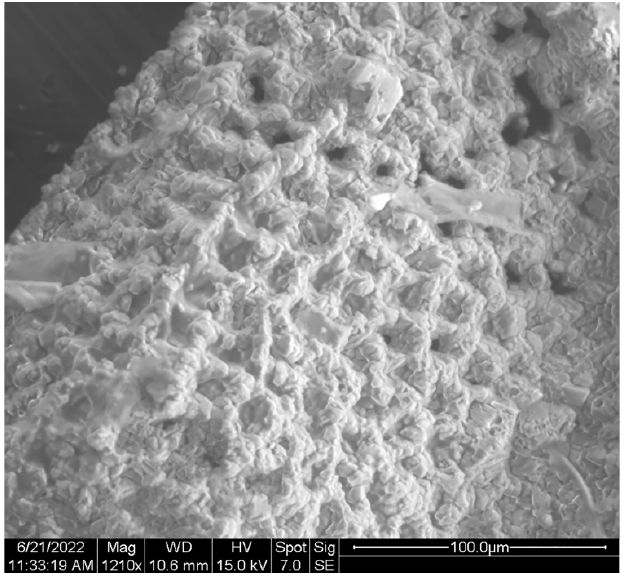
Figure 5. Kirkbya panamintensis nov. sp., detail of left valve. IGM 5011(2). Scanning electron micro- graph (secondary electron). Image shows the occlusion of reticulate valve surface pores by silica (quartz) mineralization. Scale bar = 100 microns.